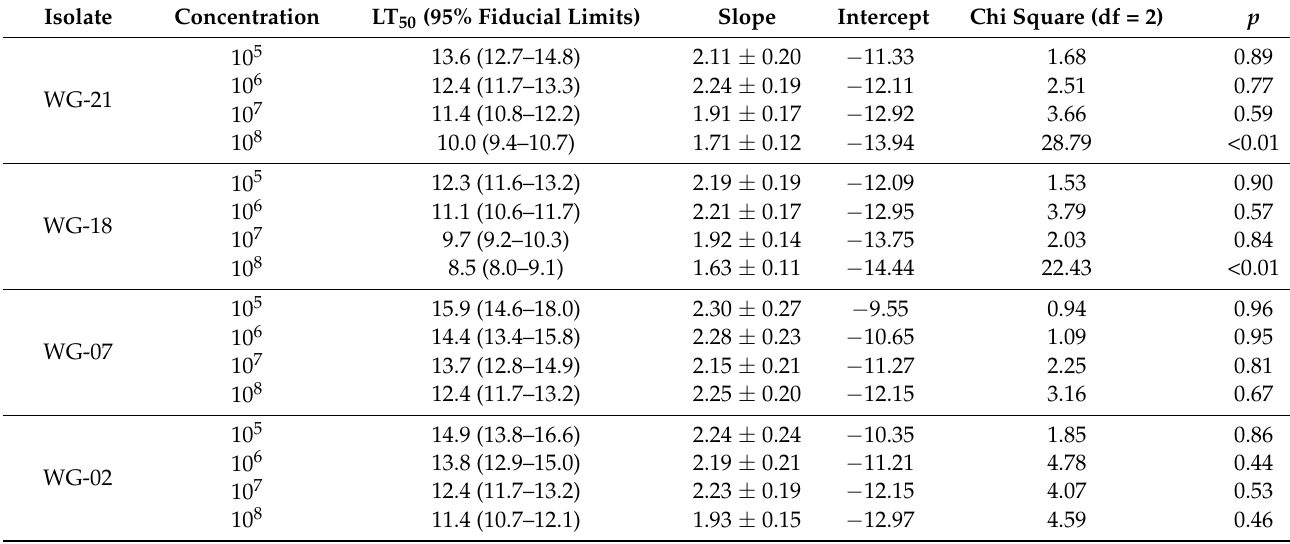
Table 5. Probit analysis estimates of lethal time (days) required to kill 50% (LT 50 ) of adult of B. dorsalis along with their 95% fiducial limits. p value represents the goodness of fit test.